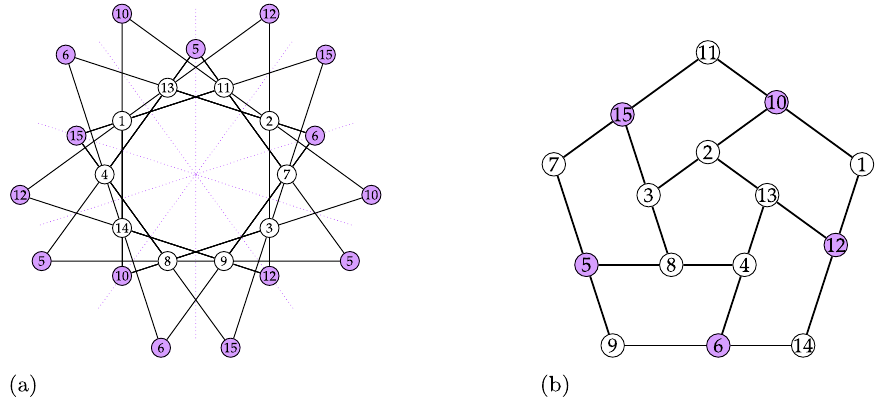
Figure 8: The 15 310 - con fi guration along with its induced triangular matroid. ( a ) 15 310 - con fi guration, ( b ) induced triangular matroid.